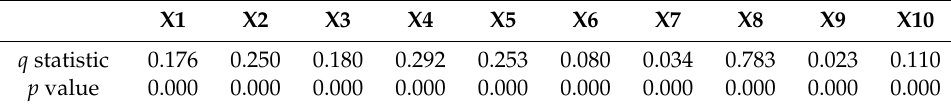
Table 6. q statistic and p values of detection factors in